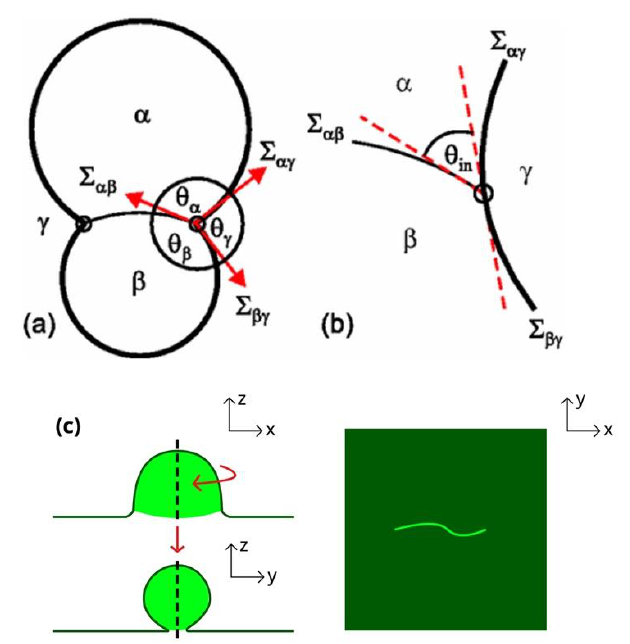
Figure 3. ( a ) A budding vesicle encapsulating phases α and β and surrounded in phase γ . On a macroscopic scale, three apparent contact angles ( θ α , θ β , and θ γ ) may be measured at the point where the boundary between liquid phases contacts the membrane; ( b ) The membrane is in fact locally smooth at this intersection; the intrinsic contact angle ( θ in ) of the α -droplet with the membrane is the angle between the tangent planes to the membrane and to the liquid phase boundary. ( c ) During membrane engulfment of a nanodroplet, symmetry is broken; the line tension is negative so a long contact line minimizes line energy while the contact area between the separate liquid phases is reduced, creating a “lipped” membrane neck. The plane of the x-z cross section is shown by the dotted line in the y-z cross section and vice versa. The plane of the membrane is shown in x-y. Dark green represents the lipid bilayer and light green the droplet; ( a , b ) reproduced from Kusumaatmaja, Li, Dimova, and Lipowsky